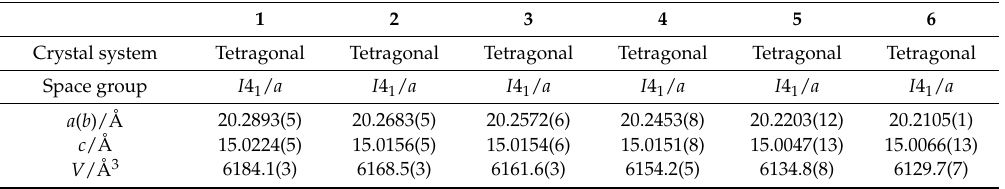
Table 1. Crystal system, space group, and lattice constants of 1 – 6